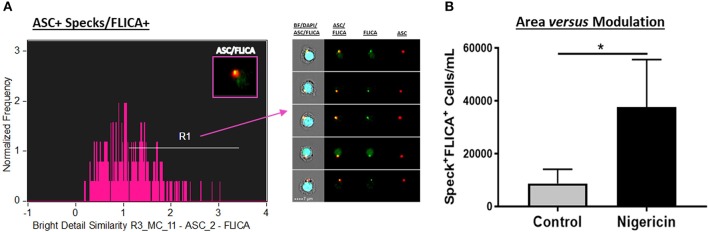
Co-localization of active caspase-1 with ASC Specks in Nigericin stimulated-CD14+ monocytes. (A) Histogram of Bright Detail Similarity R3_MC_11-ASC_2-FLICA inside Speck+ gate better identifies ASC specks with co-localized FLICA signal in in pam3csk4 (0.5 ug/mL, 3 h)- primed and Nigericin (3,5 uM, 1 h)-stimulated PBMCs. On the right side of the graph, representative images of Speck+FLICA+ monocytes were selected, showing, respectively: Composite image containing the fluorescences of ASC, FLICA, and DAPI with BF (brightfield), followed by Composite image of FLICA and ASC, and both fluorescences alone. Intensity fluorescence was augmented for the purpose of imagery, not affecting results and statistics. (B) Quantification of Speck+FLICA+ monocytes/mL in Control vs. Nigericin-stimulated cultures after Bright Detail Similarity R3_MC_11-ASC_2-FLICA Feature was applied in all data set. Numbers are the means ± SEM (n = 5). *P < 0.05 when Mann-Whitney test was applied.